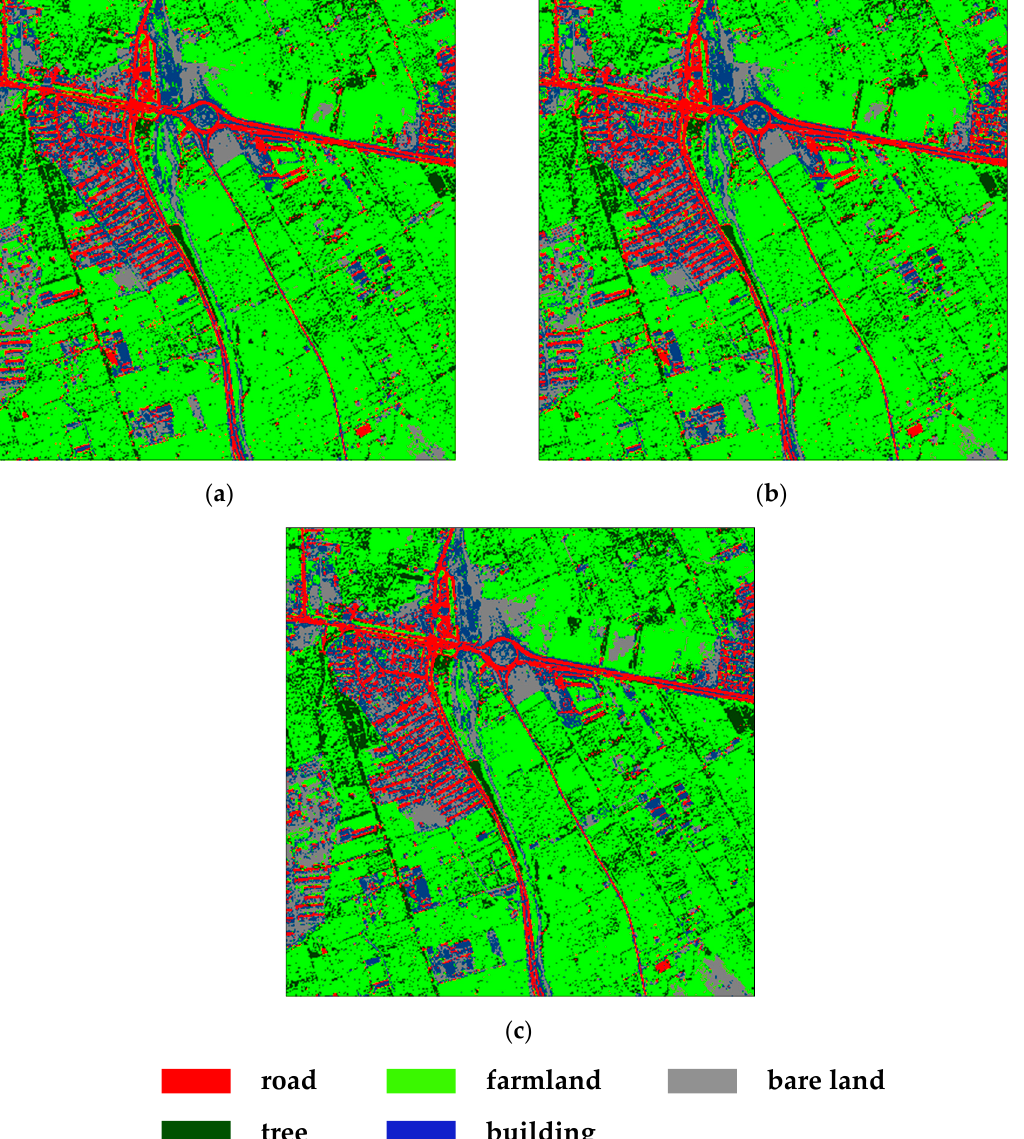
Figure 4. Classification results of HDCA, SVM and MLC algorithms. ( a ): ‘HDCA’, ( b ): ‘SVM’, ( c ): ‘MLC’.